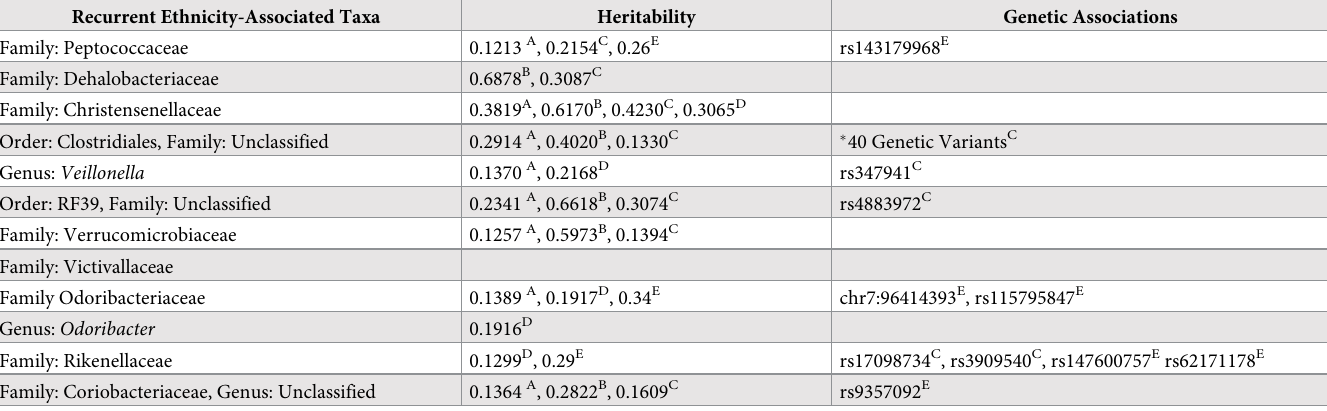
Table 1. Most recurrent ethnicity-associated taxa are previously reported heritable and genetically-associated taxa. The table shows population genetic heritability estimates and associated genetic variants for the 12 recurrent ethnically varying taxa. The minimum heritability cutoff was chosen as > 0.1, and only exactly overlapping taxonomies were considered. Studies examined A UKTwins (2014, “A” measure of additive heritability in ACE model) [34], B Yatsunenko (2014, “A” measure of additive heritability in ACE model) [34], C UKTwins (2016, “A” measure of additive heritability in ACE model) [35], D Lim (2016, H2r measure of polygenic heritability in SOLAR [41]) [39], and E Turpin (2016, H2r measure of polygenic heritability in SOLAR [41])